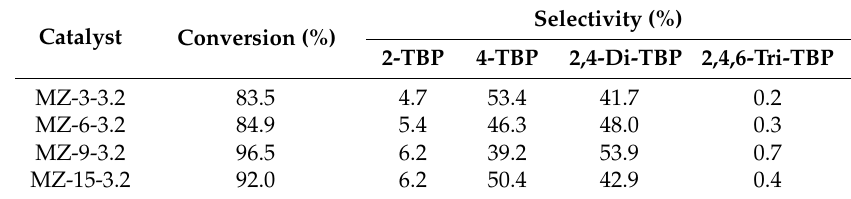
Table 2. The reaction results of the alkylation of phenol with tert-butanol. a